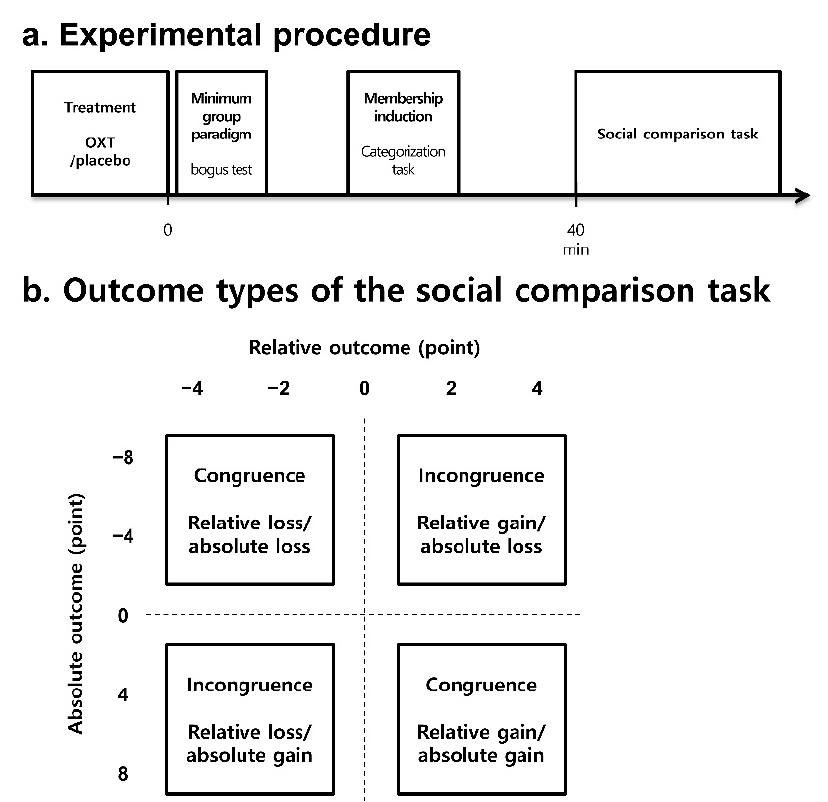
Figure 1. ( a ) Experimental procedure. Following the self-administration of OXT or placebo, the participants learned about in-group and out-group members via the minimal group paradigm and performed the categorization task designed for membership induction. Approximately forty minutes after the administration, they performed the social comparison task. ( b ) Outcome types of the social comparison task. The absolute outcomes ranged from − 8 to +8, and the relative outcomes determined by the difference between the outcomes of the participants and those of the partners ranged from − 4 to 4. The congruence condition included relative loss/absolute loss and relative gain/absolute gain trials, whereas the incongruence condition contained relative loss/absolute gain and relative gain/absolute loss trials.